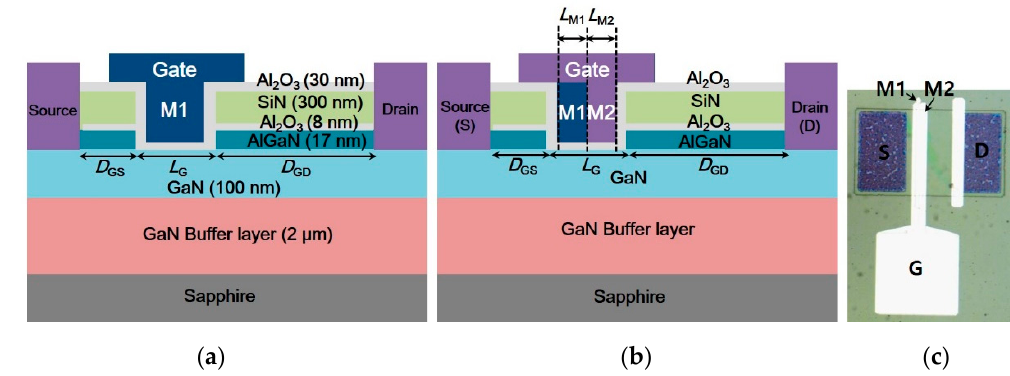
Figure 1. Schematic cross-sections of the recessed-gate GaN metal–oxide–semiconductor field-effect transistor (MOSFET) with ( a ) the single-metal-gate (SMG) and ( b ) dual-metal-gate (DMG) structures. ( c ) Optical microscope image of the fabricated DMG-based device.